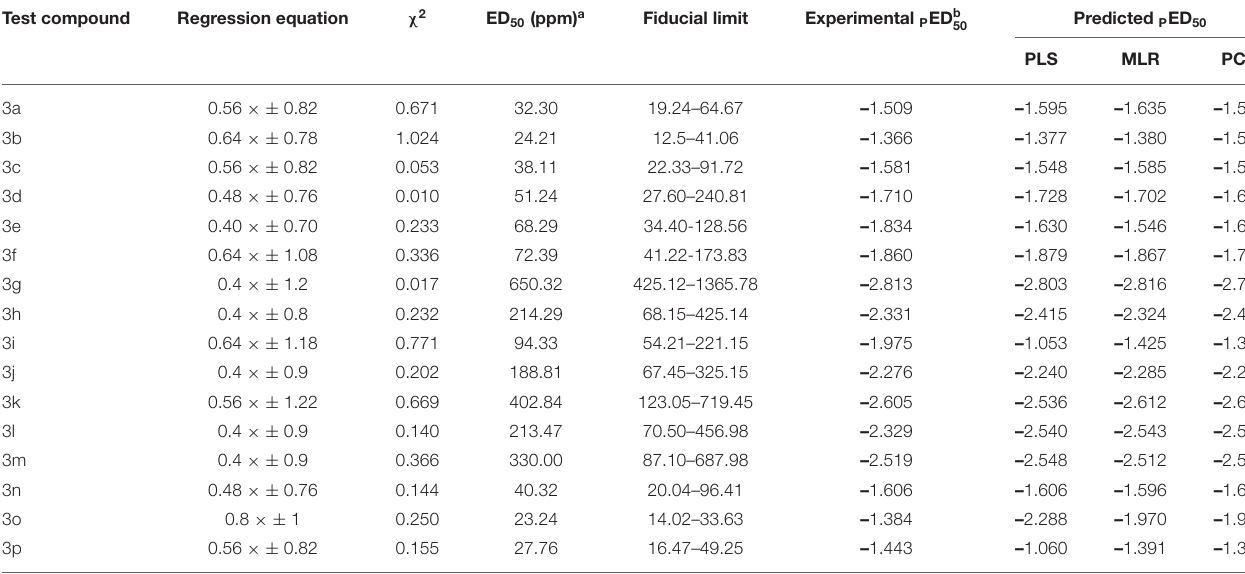
Table 2A | Experimental and predicted fungicidal activity of ferrocenyl chalcones against S. rolfsii . Test